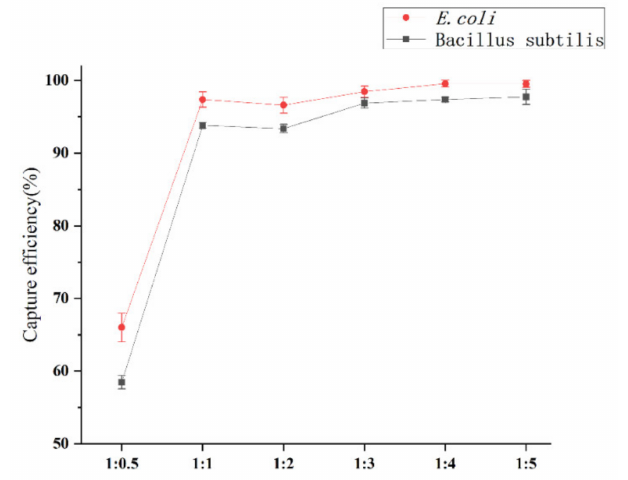
Figure 10. Capture Efficiency of Different Proportions of Fe 3 O 4 @PDA@PEI MBs (1 mg · mL − 1 ) and